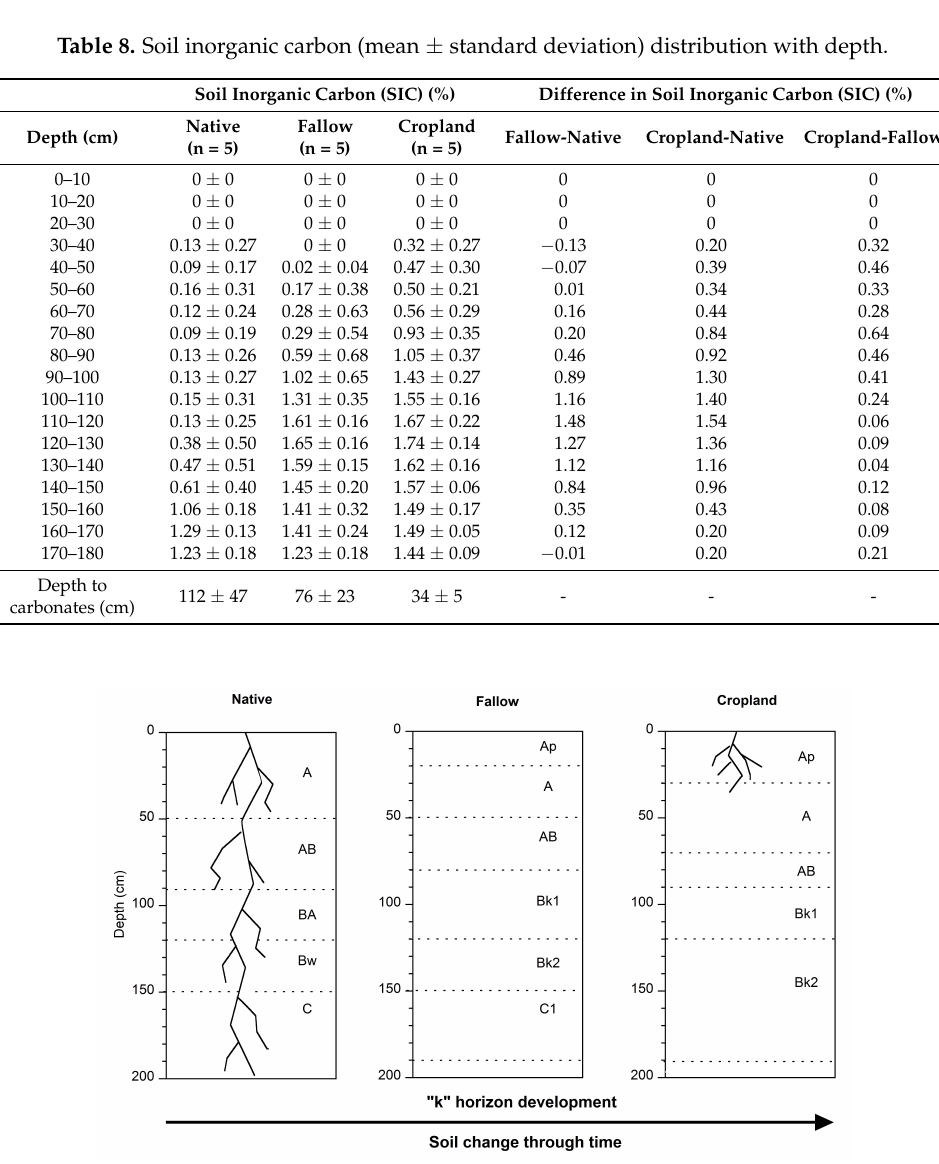
Figure 4. Model of carbonate horizon formation in soils through time as a result of cultivation of native